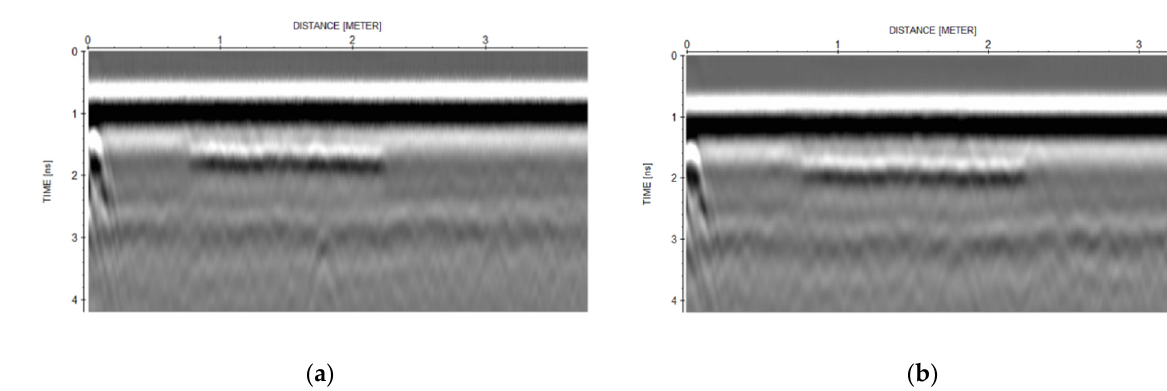
Figure A1. 1.5 GHz impulse B-scans performed on geotextile (I-12) at ( a ) 396 K and ( b ) 720 K loadings.